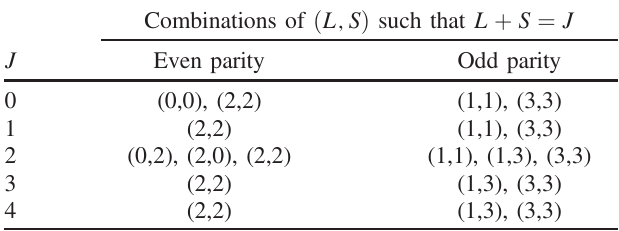
TABLE I. Lowest-order pairing multiplets. Summary of the pairing multiplets ð L; S ; J Þ up to L ¼ 2 and J ¼ 4 . The leading- and subleading-order s - and p -wave pairings (i.e., L ¼ 0 and L ¼ 1 ) are most relevant when considering pairing instabilities of topological semimetals. The pairing functions J latter pairing channels, see Eq. (7), can be found in Ref.